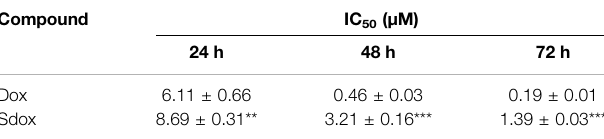
TABLE 8 | Effects of Dox and Sdox on HepG2 cell viability. Compound